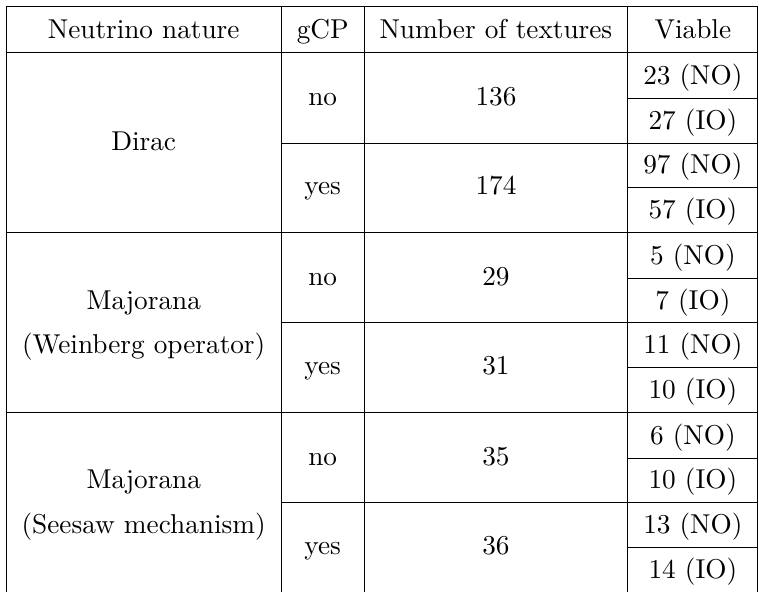
Table 12. Grand summary of the TZLM compatibility analysis. We show the number of texture pairs with no more than 9 real input parameters which can be realised via T 0 modular symmetry (third column) with and without gCP (second column). The number of phenomenologically viable cases (i.e. those which are able to fit the data at the 3 σ level) is given in the fourth column for both NO and